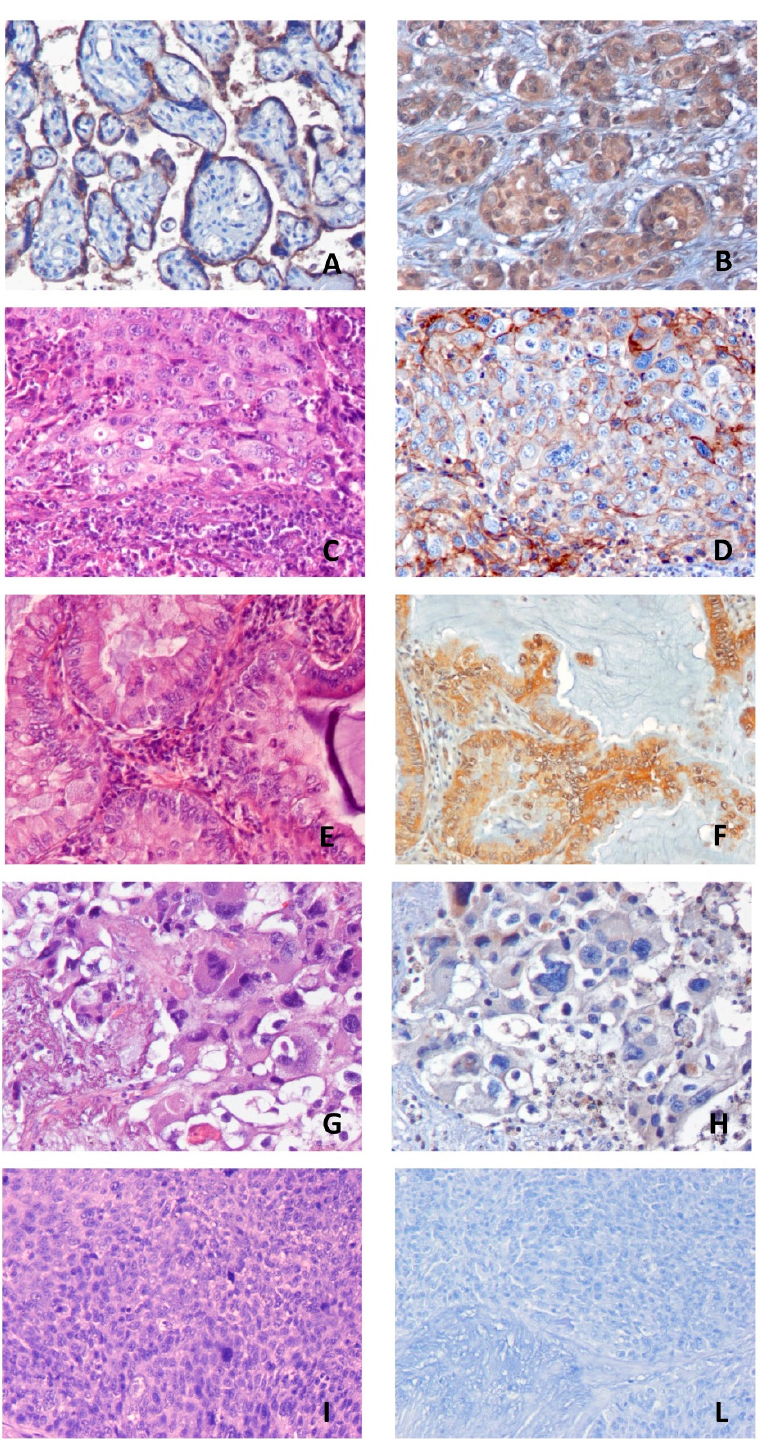
Figure 1. Representative images of immunohistochemistry (IHC) positive controls ( A , B ) and tumor samples from the Nivolumab Cohort ( C – L ). ( A ): positive PD-L1 control (placenta); ( B ): positive B7-H4 control (breast carcinoma); ( C , D ): Hematoxylin and eosin (H&E) and IHC positive staining of PD-L1; ( E , F ): H&E and IHC positive staining of B7-H4; ( G , H ): H&E and IHC negative staining of PD-L1; ( I , L ): H&E and IHC negative staining of B7-H4. All the images are at magnification 20×.